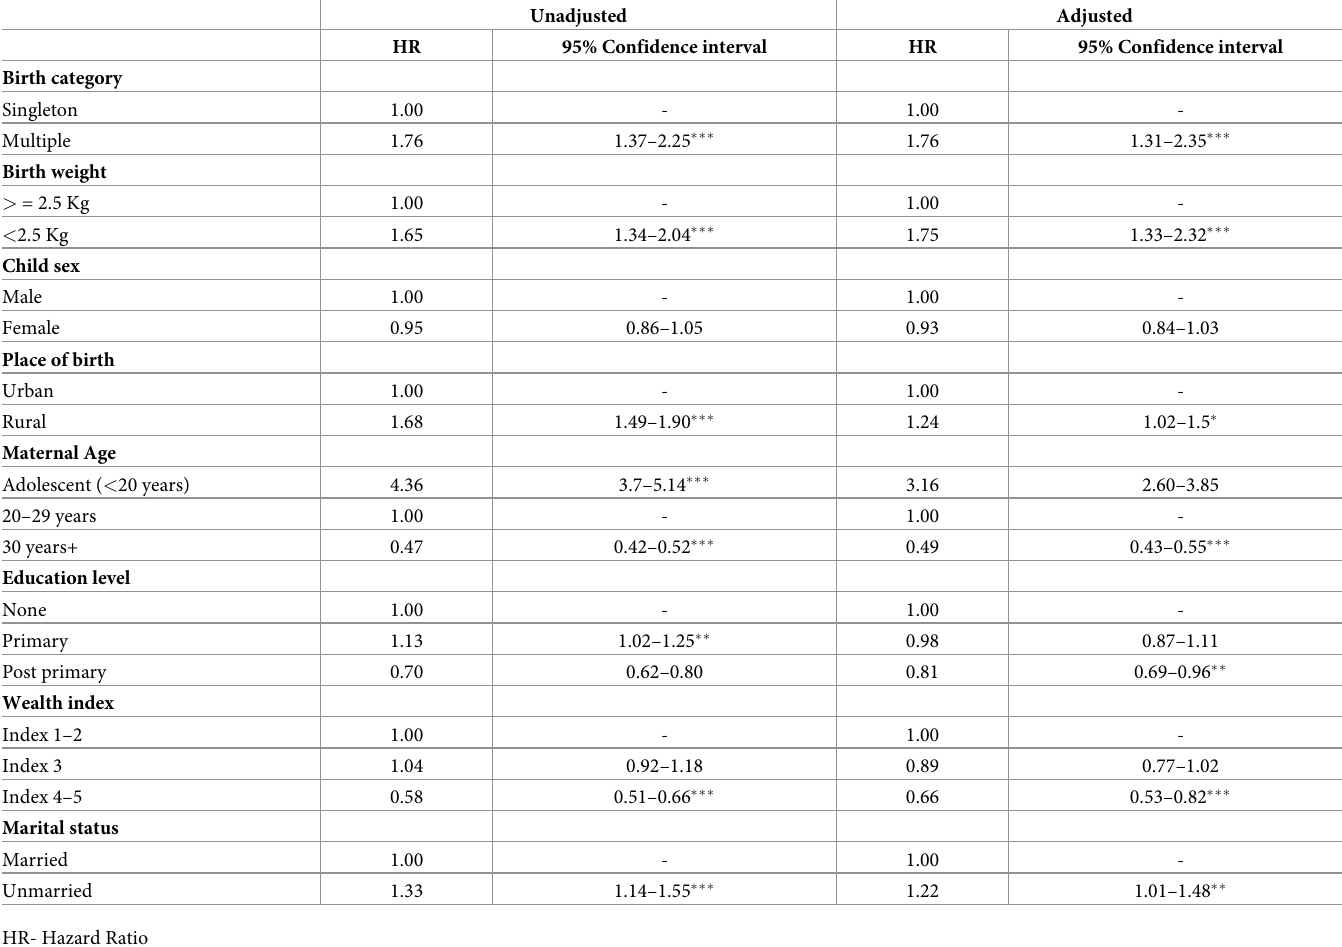
Table 5. Imputed Multivariate analysis of child mortality risk factors using 2005–2015 Iganga-Mayuge HDSS event histories